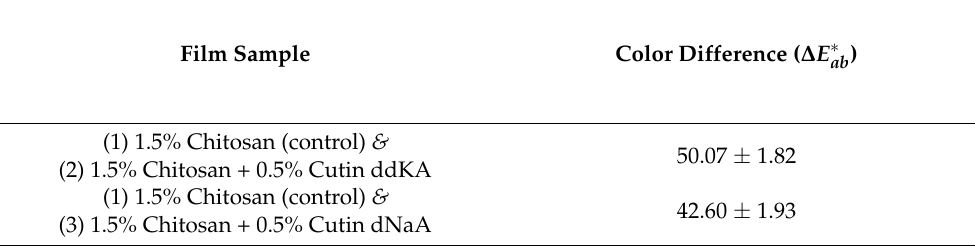
Table 11. Color difference ( ∆ E ∗ ) values between the chitosan film sample (1) and the two selected ab cutin and chitosan film samples (2) and (3).